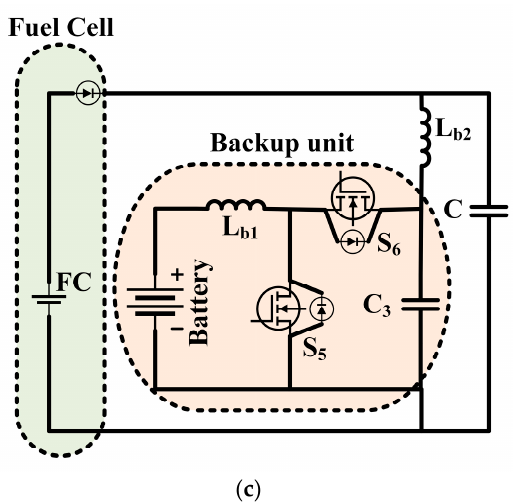
Figure 56. Converter arrangements as shown in [94]: ( a ) Cascaded connection; ( b ) Parallel connection; ( c ) Fuel cell with battery backup. Adapted from [94].